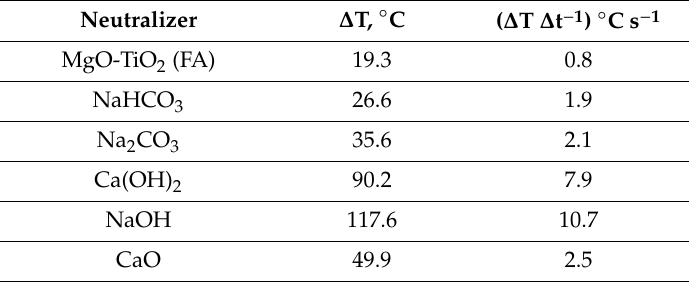
Figure 9. Temperature dependence as function of time in the process of neutralization 98% H 2 SO 4 through ( 1 ) FA (MgO-TiO 2 ), ( 2 ) NaHCO 3 , ( 3 ) Na 2 CO 3 , ( 4 ) CaO, ( 5 ) Ca (OH) 2 , ( 6 ) NaOH. Mass ratio neutralizer: H 2 SO 4 1:10. Method of adding the neutralizer: loose pouring (without mixing). T 0 = 20 °C. Table 3. Temperature increase and maximum temperature change over time for neutralization processes 98% H 2 SO 4 through FA , NaHCO 3 , Na 2 CO 3 , Ca (OH) 2 , NaOH, CaO. Mass ratio neutralizer: H 2 SO 4 1:10. Method of adding the neutralizer: loose pouring (without mixing). T 0 = 20 °C.